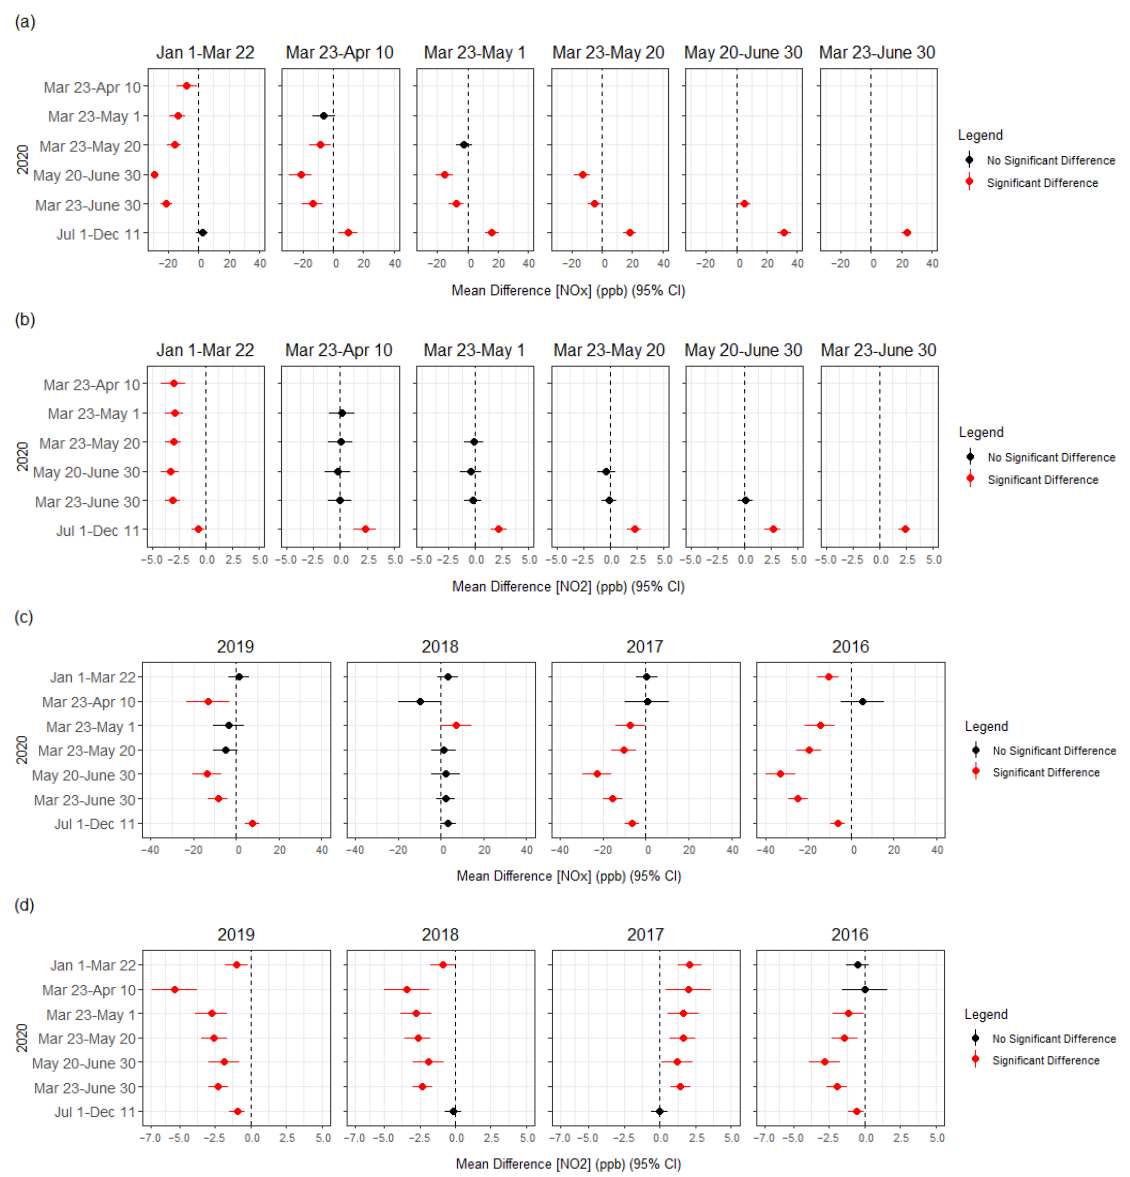
Figure 17. Post hoc test for intra-annual and interannual NO X (Near Road) and NO 2 (Taft) concen- tration comparisons: ( a ) intra-annual at Near Road; ( b ) intra-annual at Taft; ( c ) interannual at Near Road; ( d ) interannual at Taft. The circles represent the difference in mean NO X concentration between the two time periods on each axis along with the 95% confidence interval (e.g., top left of top figure: (mean NO X 23 March–10 April) − (mean NO X 1 January–22 March) = − 7.64